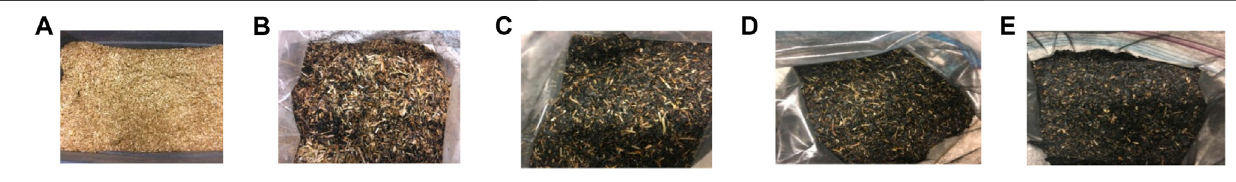
Frontiers in Energy Research |